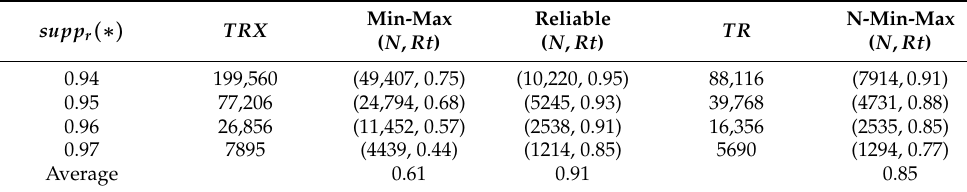
Table A9. Number of approximate rules and reduction in the connect-4 database with confidence c ≥